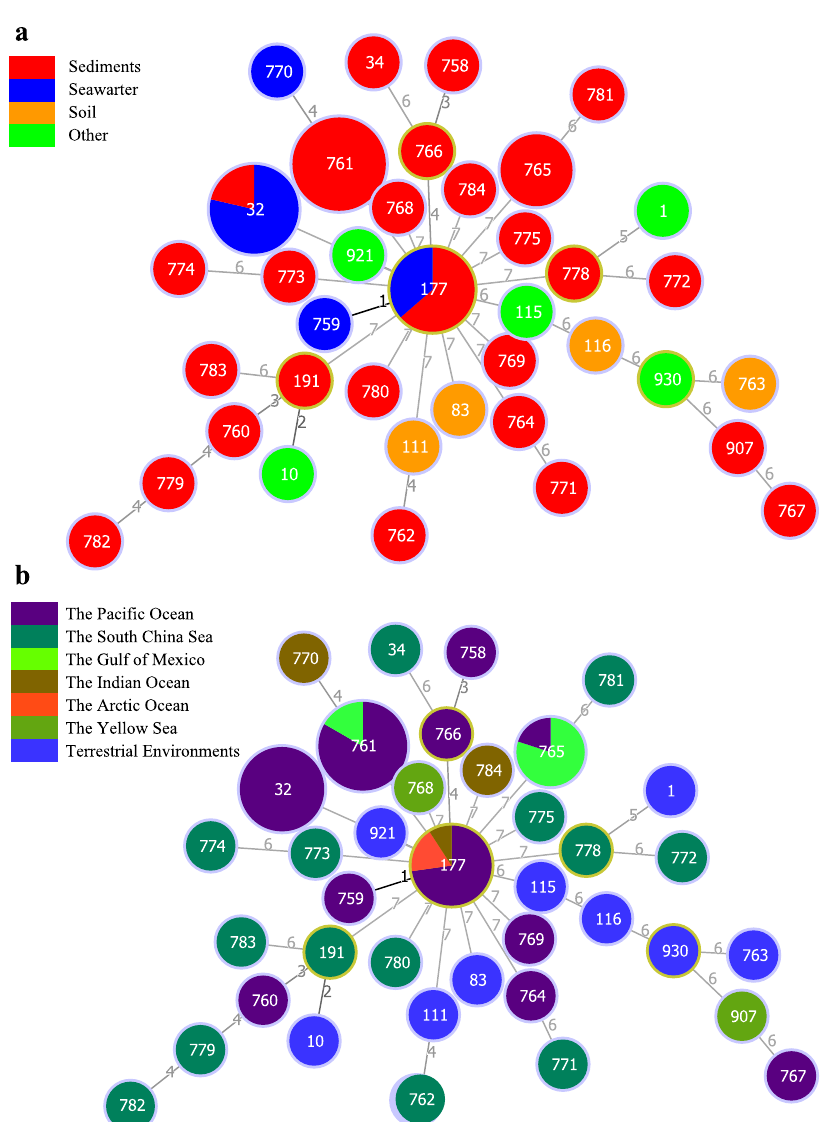
Figure 1. Minimum spanning tree reflecting clonal relationships of sequence types (STs) for 82 B. cereus group bacteria constructed using goeBURST. Each ST is represented by a circle, and the size of the circle is logarithmically proportional to the number of strains represented by the ST. Exact numbers of isolates per ST are given in Supplementary Table S1. The numbers connecting the circles indicate the number of genes of difference genes between isolates. ( a ) The isolates are colored according to isolated samples, as given in the key at upper left. ( b ) The isolates are colored according to isolated areas, as given in the key at middle